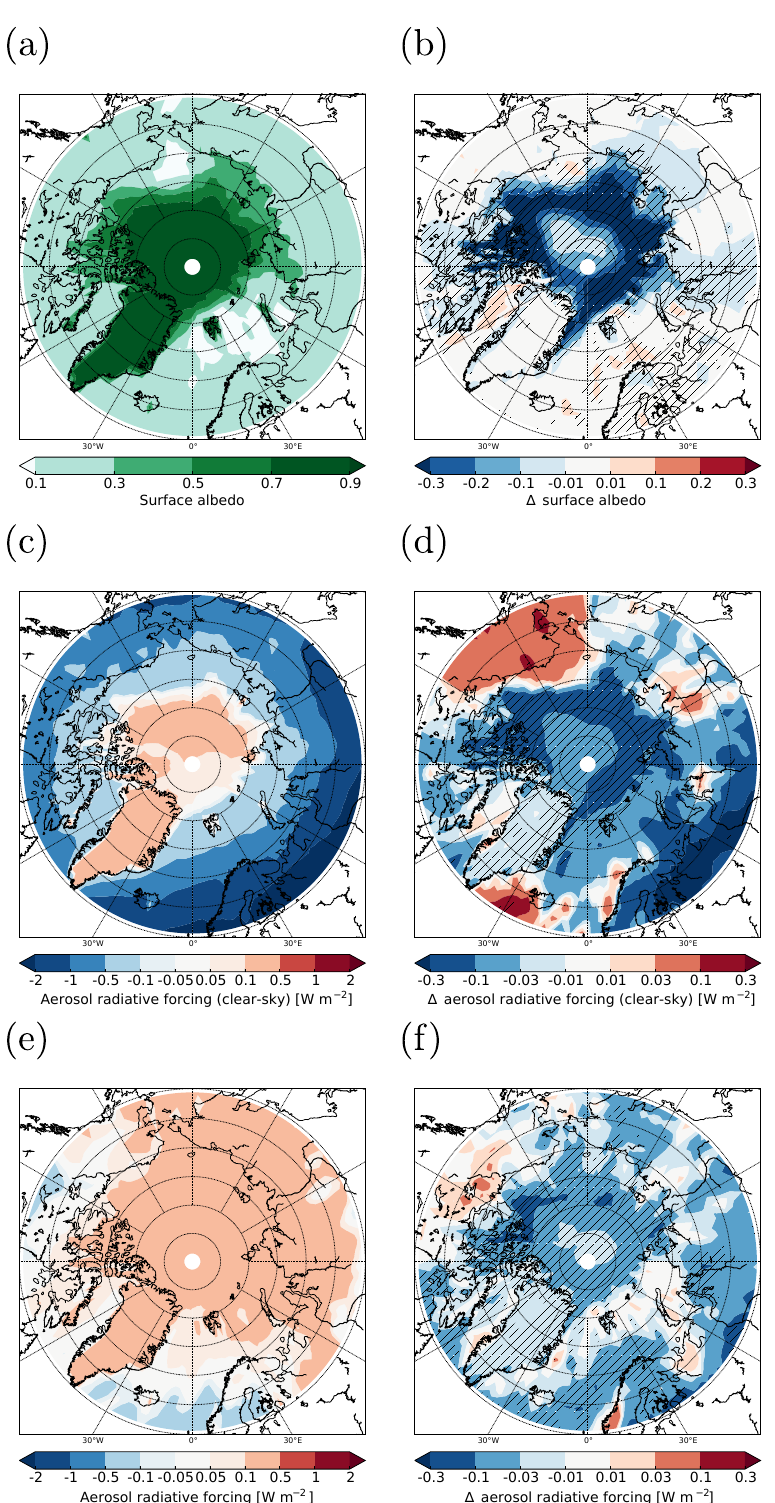
Figure 7. Surface albedo, aerosol net radiative forcing (clear-sky), and aerosol net radiative forcing (all sky) in 2004 in (a) , (c) , and (e) and differences between 2050 and 2004 (i.e. between simulations arctic_2050_EM2004 and arctic_2004) in (b) , (d) , and (f) in early autumn (September–October). Hatched areas are significant at the 95% confidence